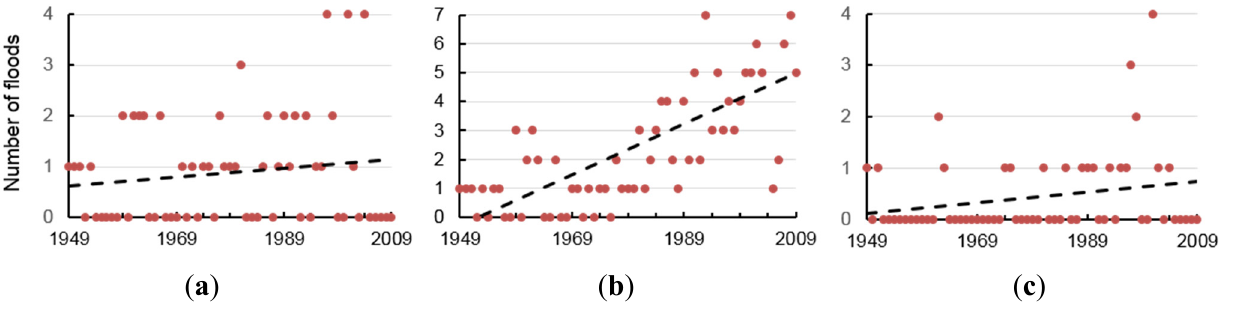
Figure 6. Trends of agricultural waterlogging ( a ); urban waterlogging ( b ); and mixed waterlogging ( c ).